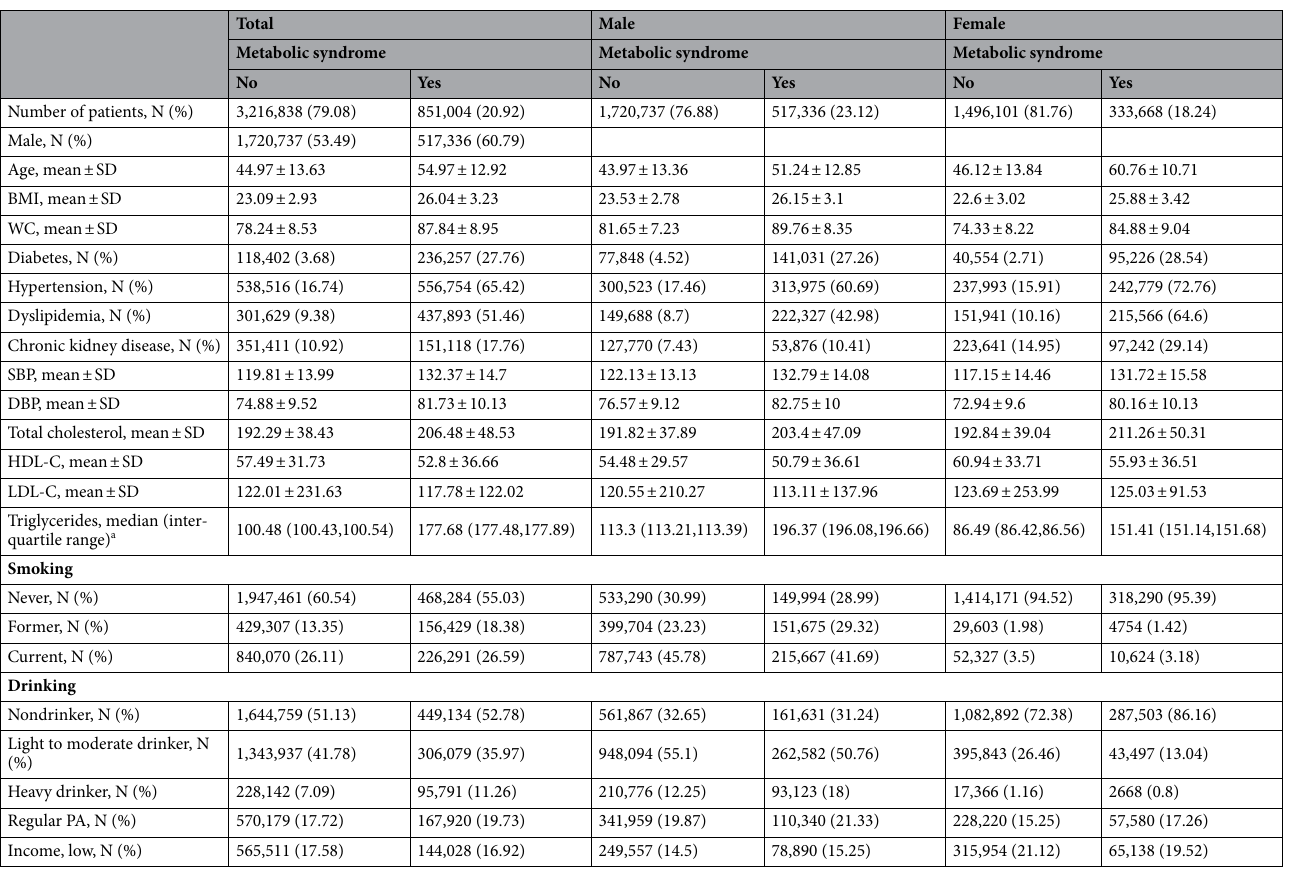
Table 1. Baseline characteristics of the study population. N number, SD standard deviation, BMI body mass index, WC waist circumference, SBP systolic blood pressure, DBP diastolic blood pressure, HDL-C high- density lipoprotein cholesterol, LDL-C low-density lipoprotein cholesterol, PA physical activity. a Geometric